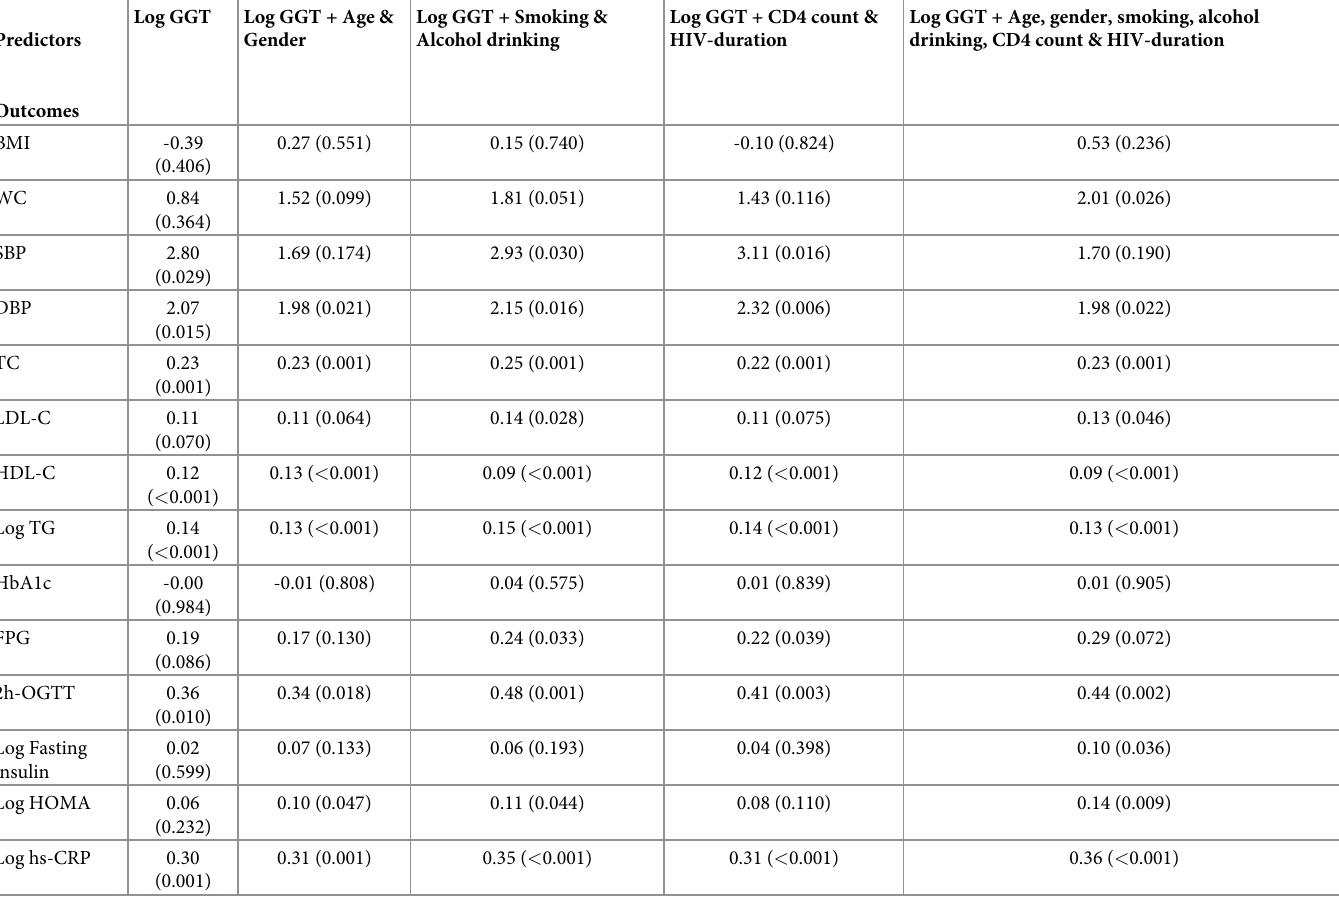
Table 4. Linear regressions for the associations of gamma-glutamyl transferase (GGT) with cardio-metabolic risk markers, based on a subset of participants whose CD4 count data were available, N=357. Predictors